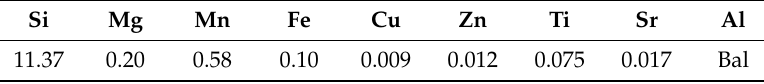
Table 1. Chemical composition of AlSiMgMn alloy (wt.